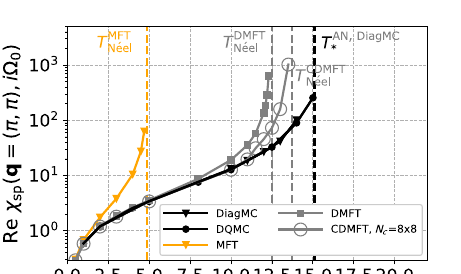
FIG. 14. Antiferromagnetic static susceptibility χ ð π ; π Þ ; i Ω n ¼ 0 ) as a function of (inverse) temperature for various methods on a logarithmic scale.